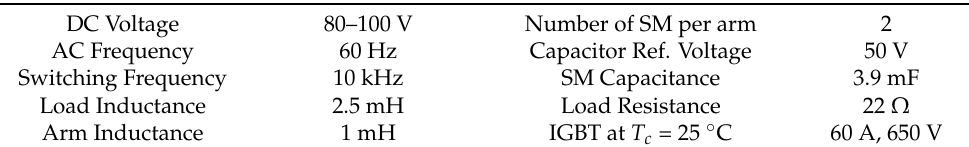
Table 1. System parameters.